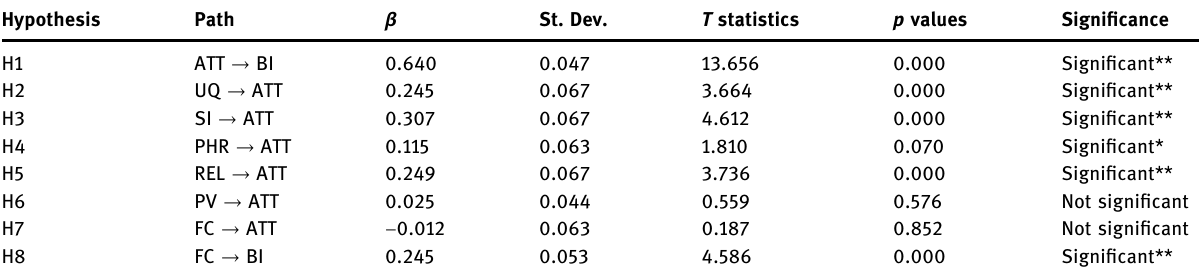
Table 6: Evaluation of hypothesis Hypothesis Path β St.